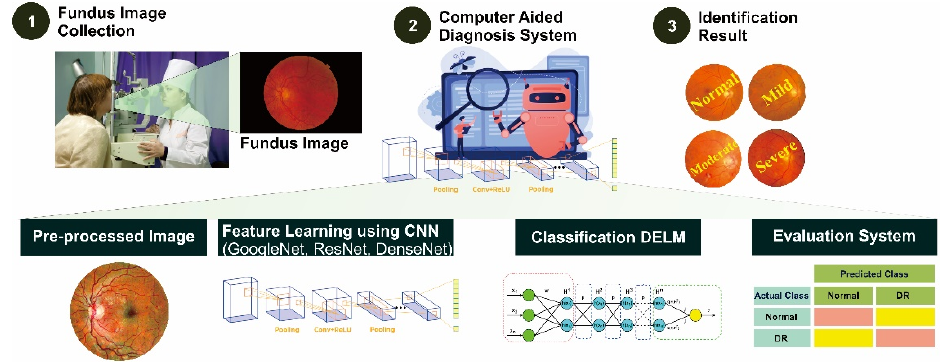
Figure 2. Graphical abstract of DR classification using CDELM method.